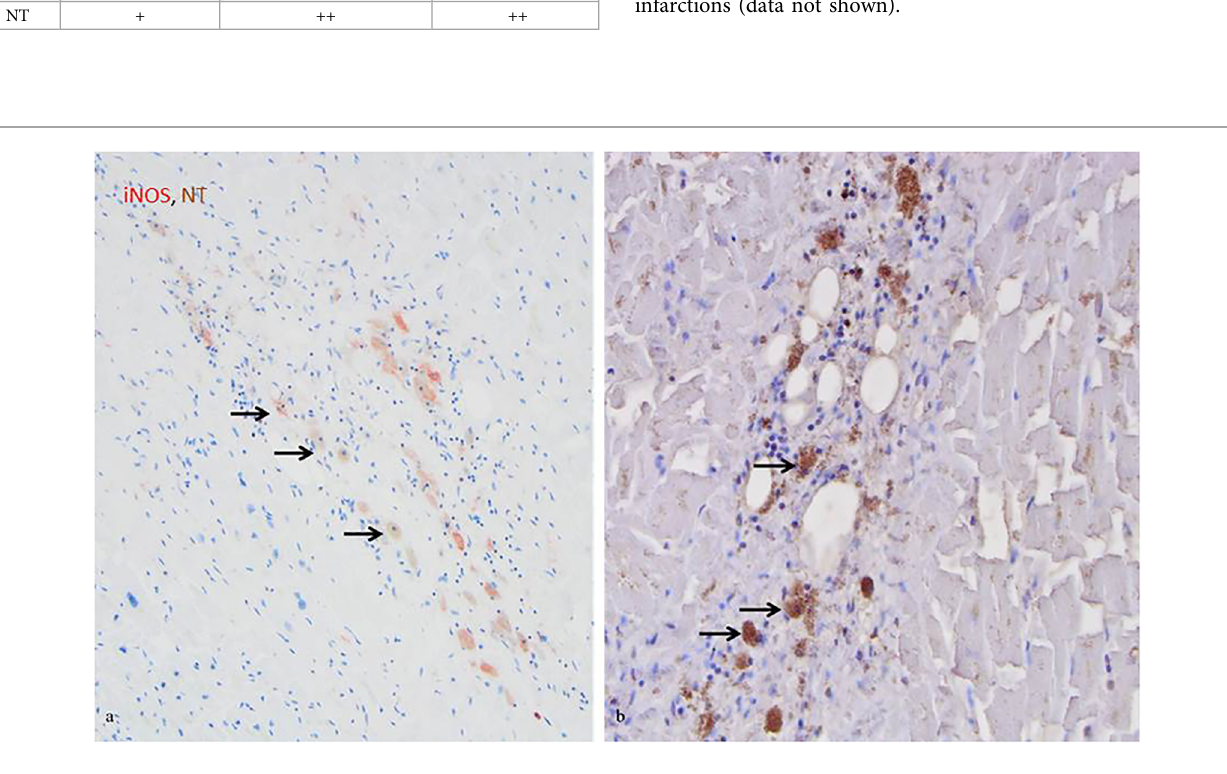
only weak staining of NT was observed ( Table 3 ). NT was mainly found in cardiomyocytes and to a lesser extent in CD68+ macrophages, indicating co-staining of iNOS and NT ( Figure 2 ). In comparison to acute and older infarctions, a reduced iNOS protein staining was detected in older infarctions. Yet, the intensity of the NT staining showed no difference between older and acute infarctions (data not shown).